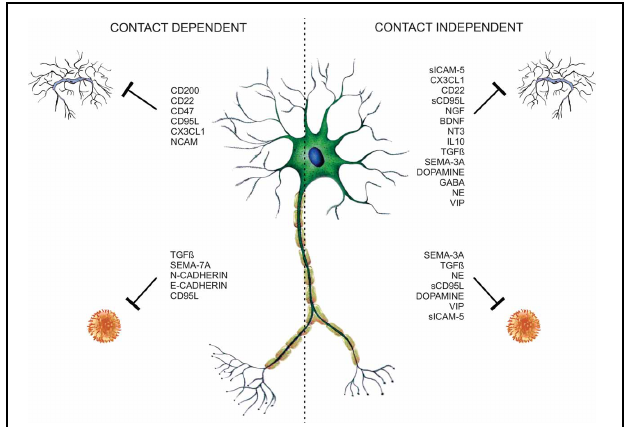
FIGURE 1 | Neuronal microglia and T-cell regulation. Neurons control T-cell and glia functions through neuronal membrane molecules or constitutive-secreted molecules like neurotrophins, neurotransmitters, neuropeptides, semaphorins, and cytokines, constituting contact-dependent and -independent regulatory